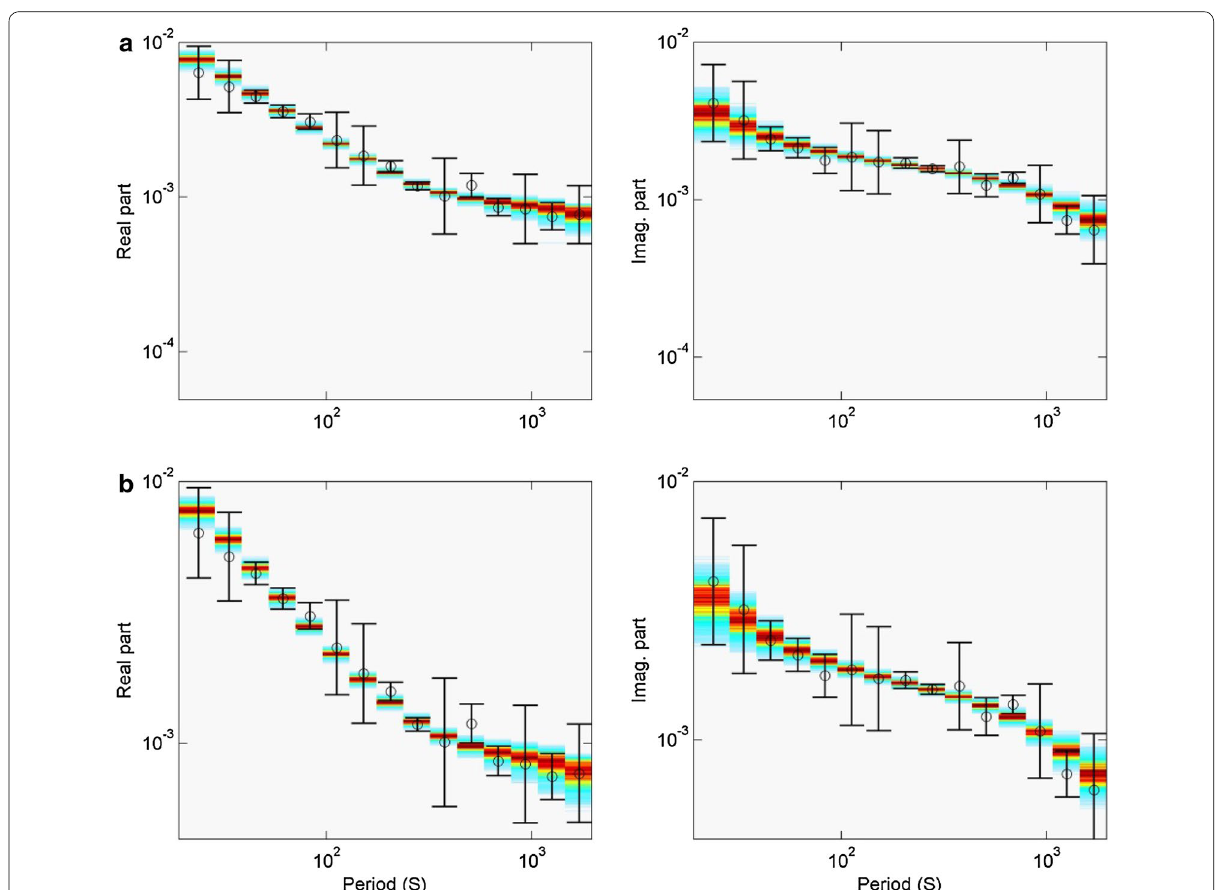
Fig. 7 Densities of the predicted data from the posterior samples for the inversions ( a ) with and ( b ) without considering the AR(1) process. Circles with error bars represent the COPROD1 data